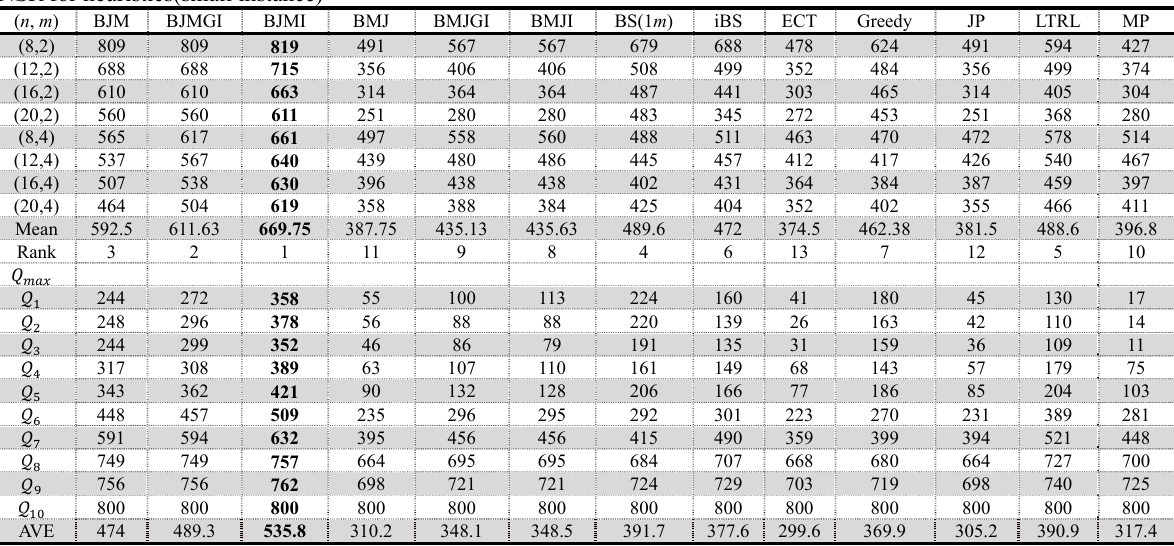
Table 4 lists the NSR of small-scale instances, which shows the advantages of the new heuristics. The best six heuristics are